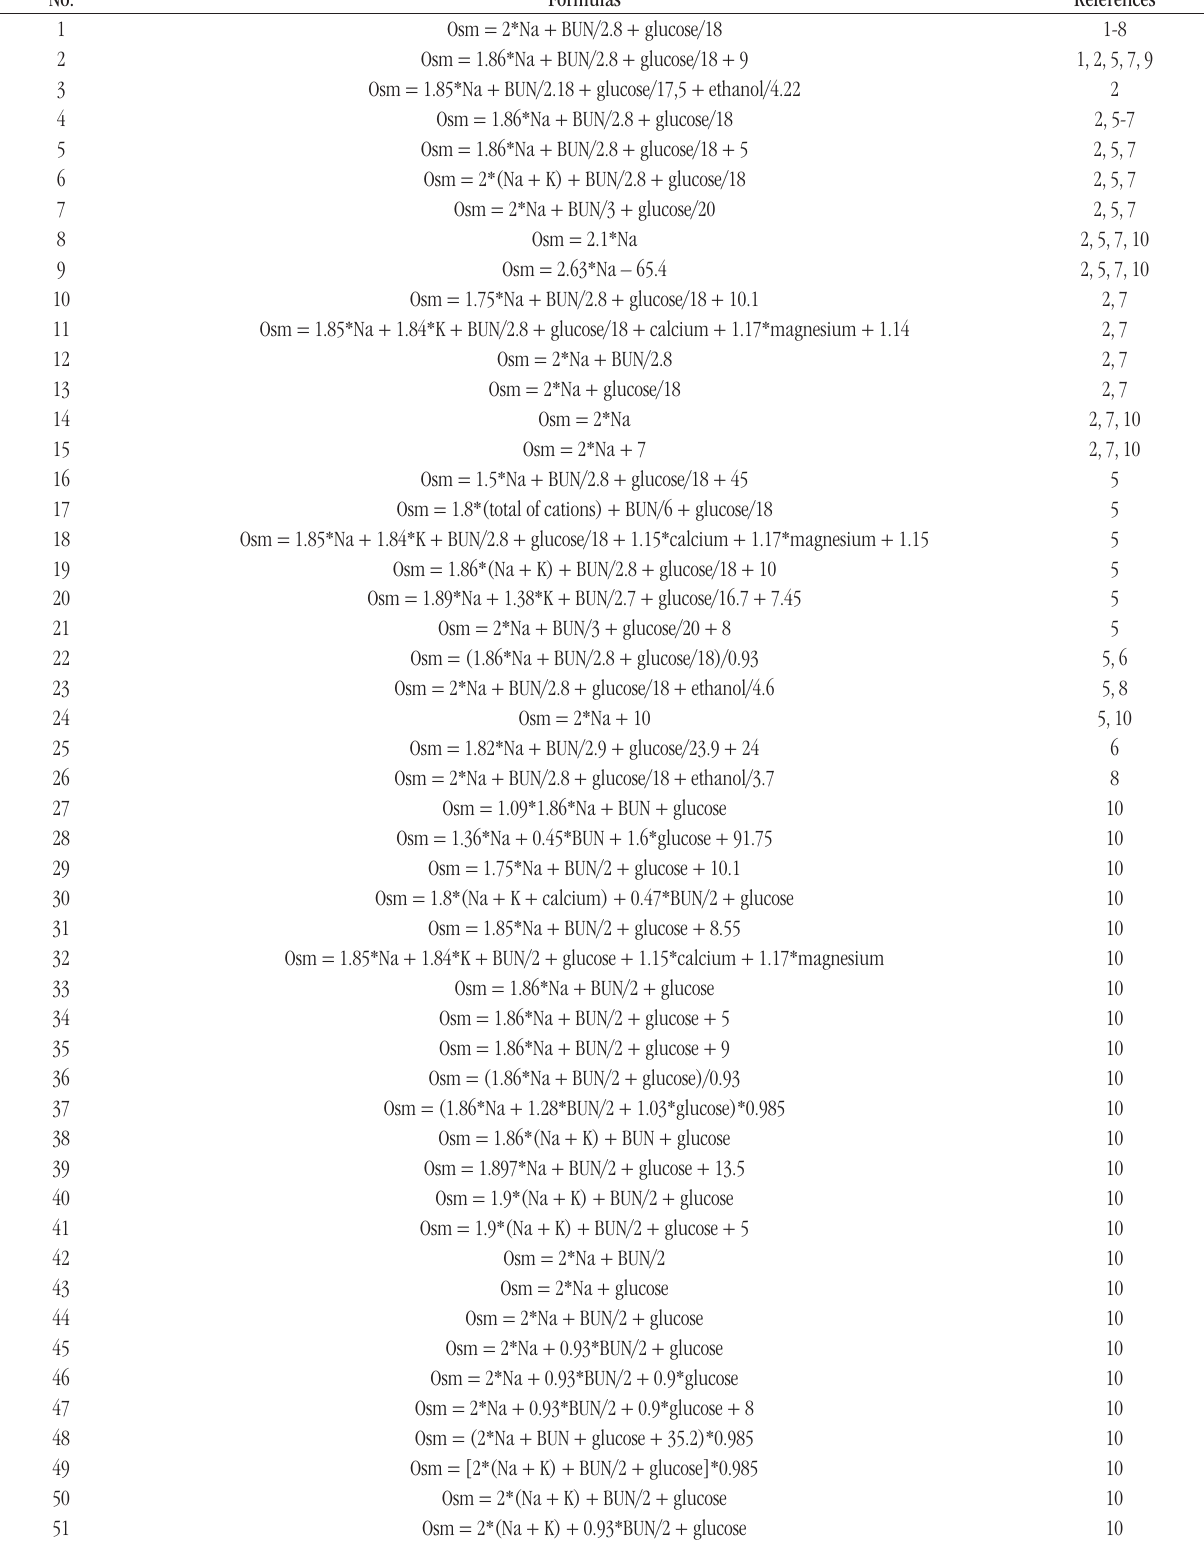
taBLE 2 − Formulas for the calculation of serum osmolality found in the PubMed search